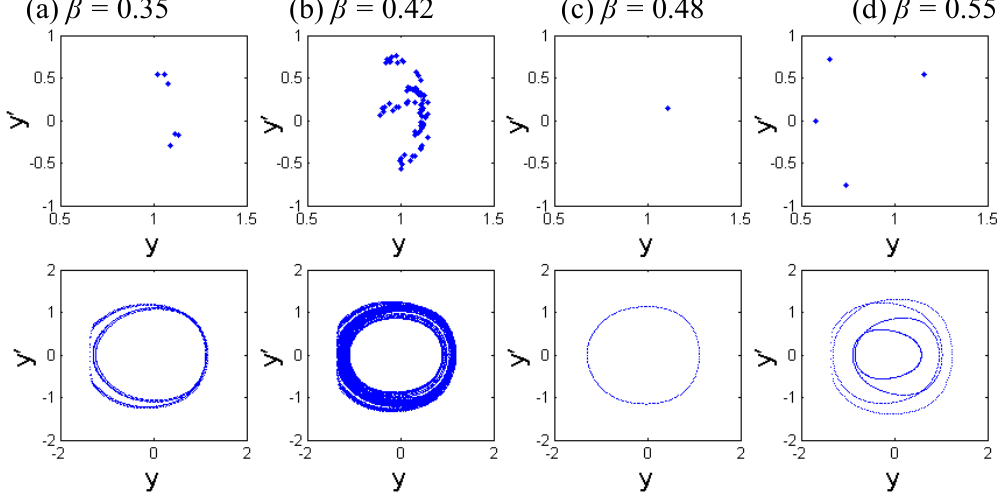
Figure 13. The Poincaré maps and phase portraits of different cubic stiffness ratios β